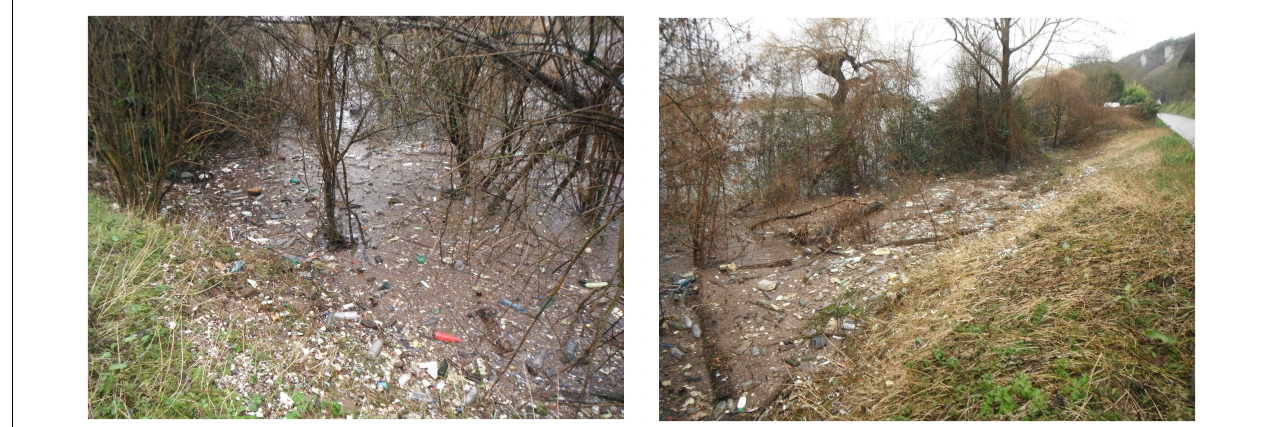
FIGURE 4 | Debris during the winter flood in 2018. Route de Muids, right riverbank, ∼ 120 km downstream Paris megacity, in February 2018, the